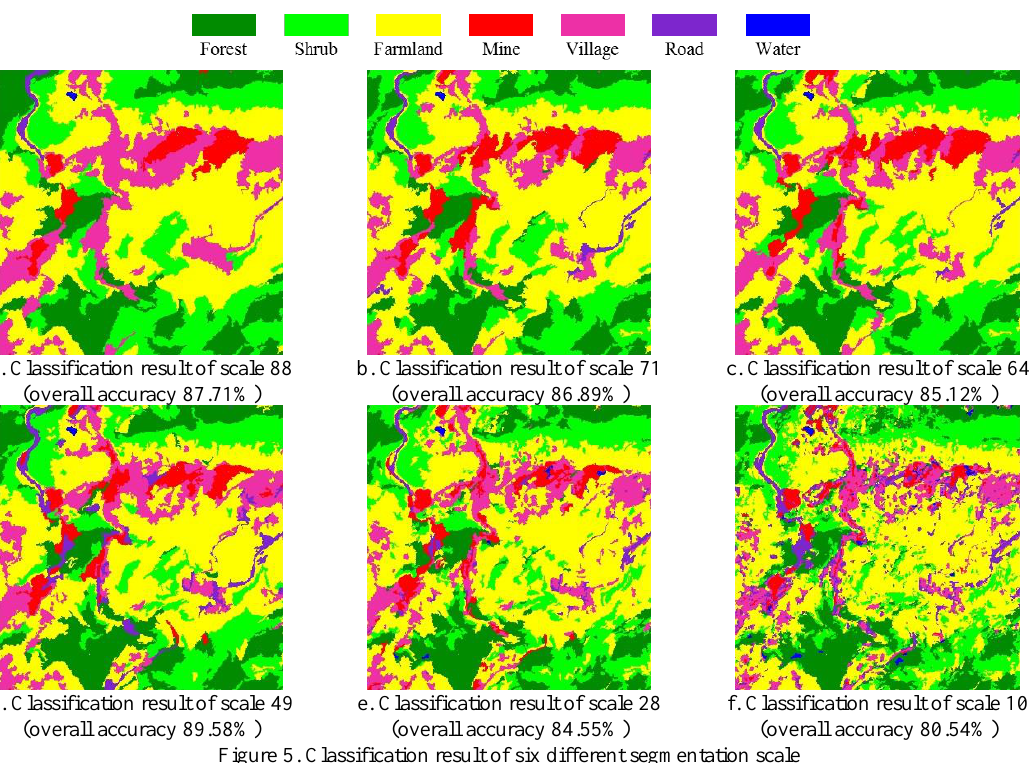
Figure 5. Classification result of six different segmentation scale